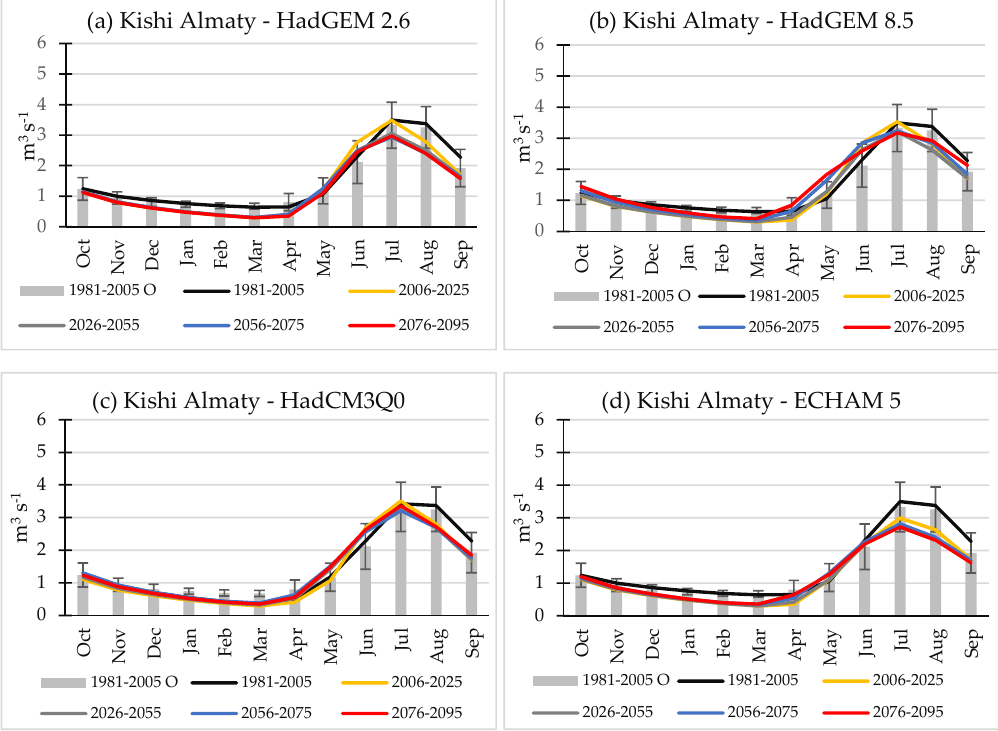
Figure 13. As in Figure 12 but for the Kishi